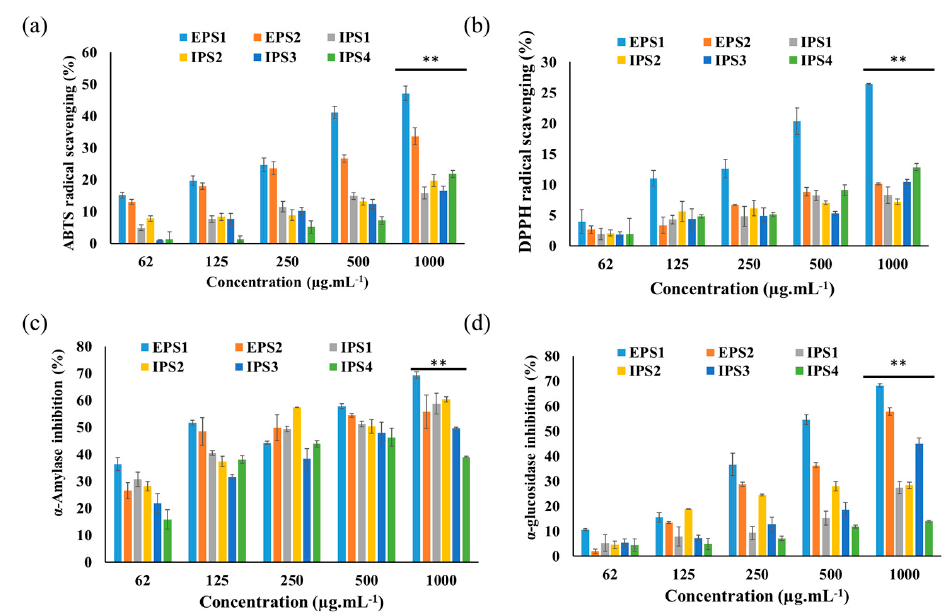
Figure 5. Antioxidant and enzyme inhibition activity of polysaccharides (EPSs and IPSs) isolated from Trichoderma spp: ABTS+ scavenging activity ( a ), DPPH free radical scavenging activity ( b ), α -amylase inhibition activity ( c ), and α -glucosidase inhibition activity ( d ). Results presented as mean ± SE (DF-2), ** p < 0.01 indicates the significance between the polysaccharides and their low concentration.